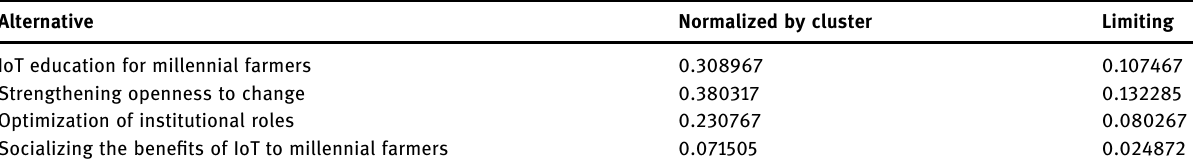
Table 7: Weight of alternative cluster